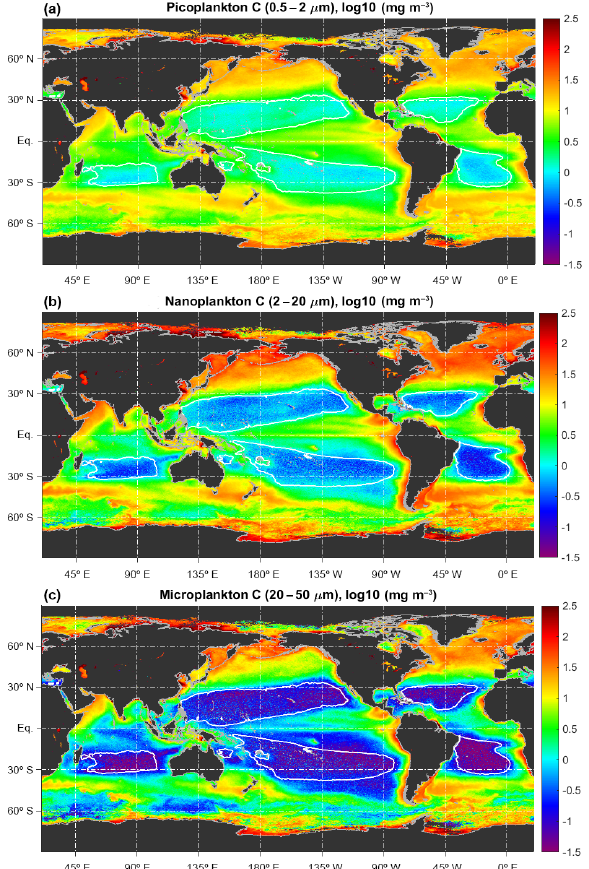
Figure 4. SeaWiFS mission composite (September 1997– December 2010) of percentage contributions of three PSCs to total phytoplankton carbon biomass, estimated with the PSD/allometric method: (a) picoplankton, (b) nanoplankton and (c) microplank- ton. This mission composite is computed by averaging the fractional contributions to C biomass for each available month (Fig. S4). The white contours are the 0.08mgm − 3 isoline of